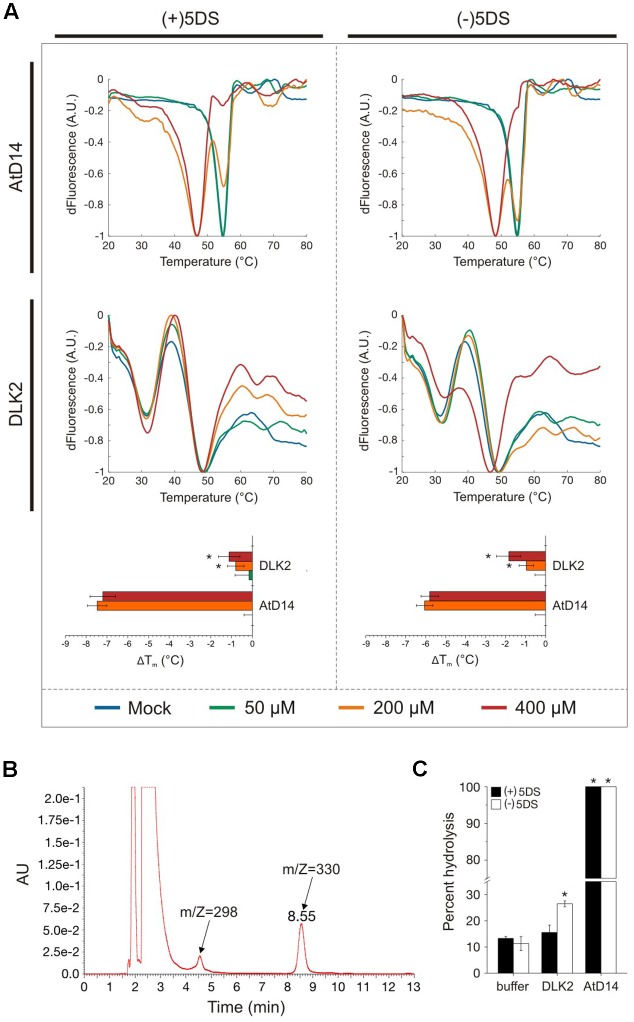
DLK2 stereospecifically binds and hydrolyses (–)5DS. (A) Differential Scanning Fluorimetry (DSF) assay curves of AtD14 and DLK2 proteins (purified from E. coli Rosetta cells) in the presence of (+) and (–)5DS. Protein-ligand mixtures with SYPRO fluorescent dye were gradually heated in a real-time PCR instrument and the change in fluorescence emission was monitored and plotted against temperature. Curve fitting was accomplished with SimpleDSFviewer (Sun et al., 2015). ΔTm is calculated as a difference from mock (DMSO) Tm; calculated Tm values of three protein samples and four technical replicates from different protein batches are shown; asterisks represent a significant difference from mock (buffer) under the same conditions (mean ± SD; ANOVA, P < 0.01). (B) (+)5DS and (–)5DS (m/Z = 330) show emission peaks at 235 nm. Peak of the putative degradation product is also shown (m/Z = 298). Amounts of deoxystrigols and degradation products were estimated as the areas of peaks. (C) Hydrolysis of (+) and (–)5DS in the presence of AtD14 and DLK2. Hydrolysis of the compounds was assessed by HPLC after 2 h of incubation at 20°C. Data represent the percentages of decrease in the peak areas of substrates. The spontaneous hydrolysis was around 10%. Measurements were repeated at least three times using different protein batches. Asterisks represent significant differences from mock (buffer) under the same conditions (mean ± SD; ANOVA, P < 0.01).